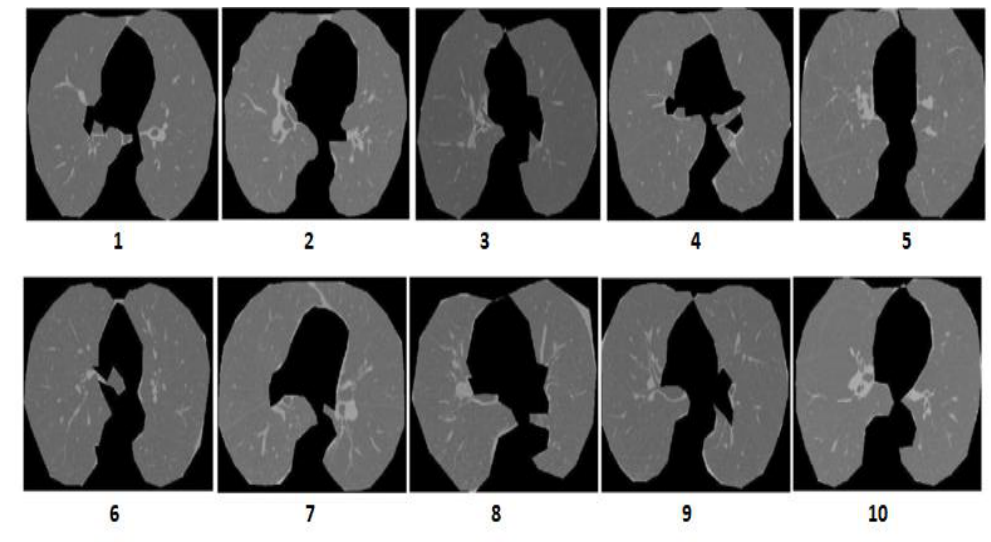
Figure 8. Sample images from 10 different classes of the I-ELCAP image database. Table 2. Comparison of Percentage Retrieval Accuracy (ARP) on the I-ELCAP database.